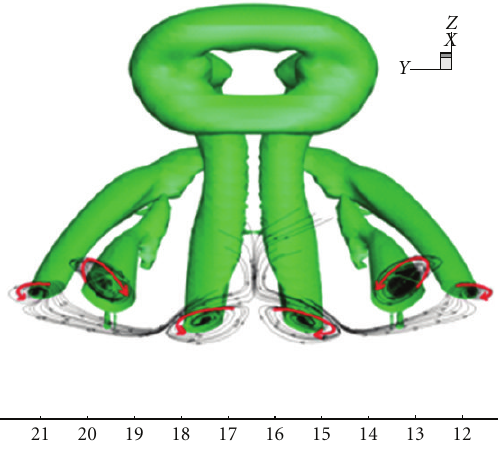
Figure 20: Isosurface of λ 2 and stream trace at x = 530 . 348 δ in